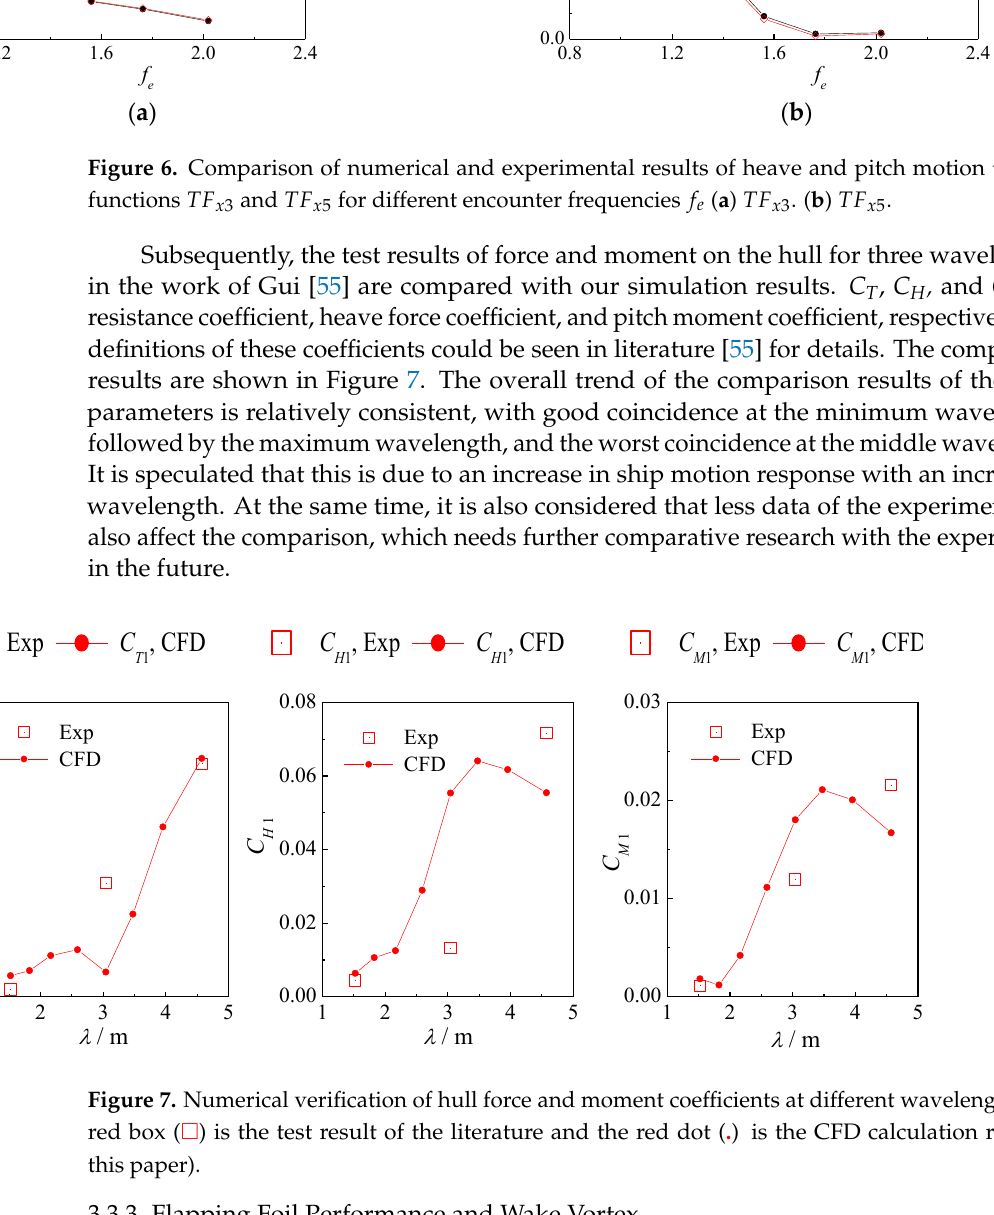
Table 3. Eight working conditions under the conditions of Fr = 0.28, wave steepness A·K = 0.05